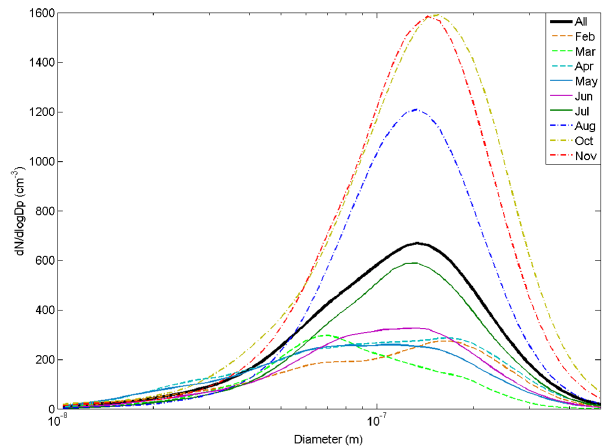
Fig. 5. Seasonal behaviour of the particle number size distribution in the Brazilian EUCAARI site. The black curve represents the mean of all seasons. The upper and lower curves are the averages of the dry and wet season,